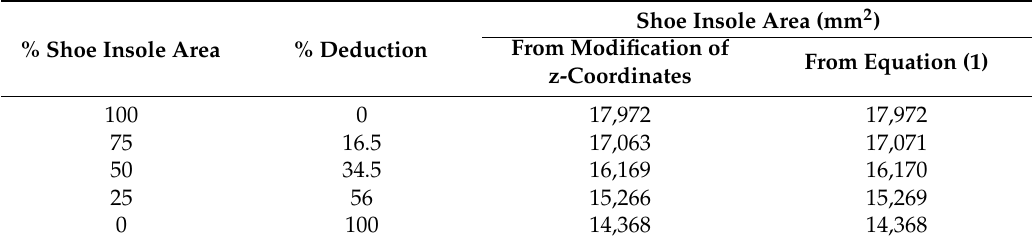
Table 3. The deduction percentage and area of shoe insole result of modification of z-coordinate and calculation using Equation (1) from one of the study